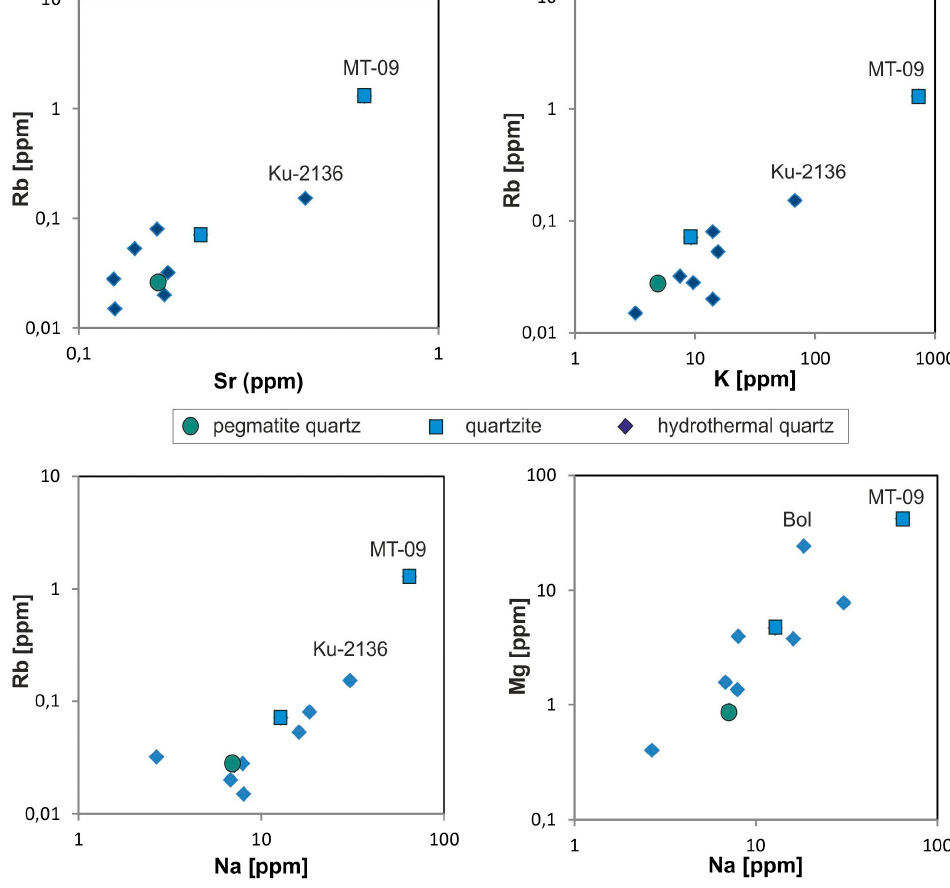
Figure 9. Element ratios of selected alkali and alkali earth elements in the investigated quartz samples (the labelled samples are those with detected mineral inclusions).